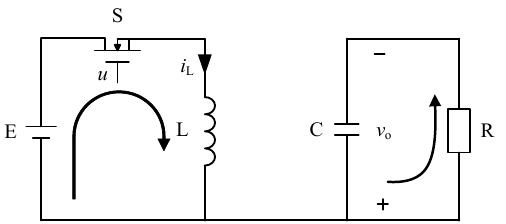
Figure 2. The equivalent circuit of the buck-boost converter when u = 1.